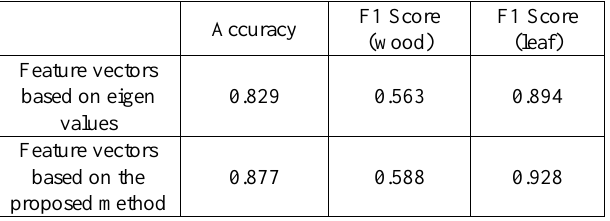
Table 2. Comparison of accuracy and F1